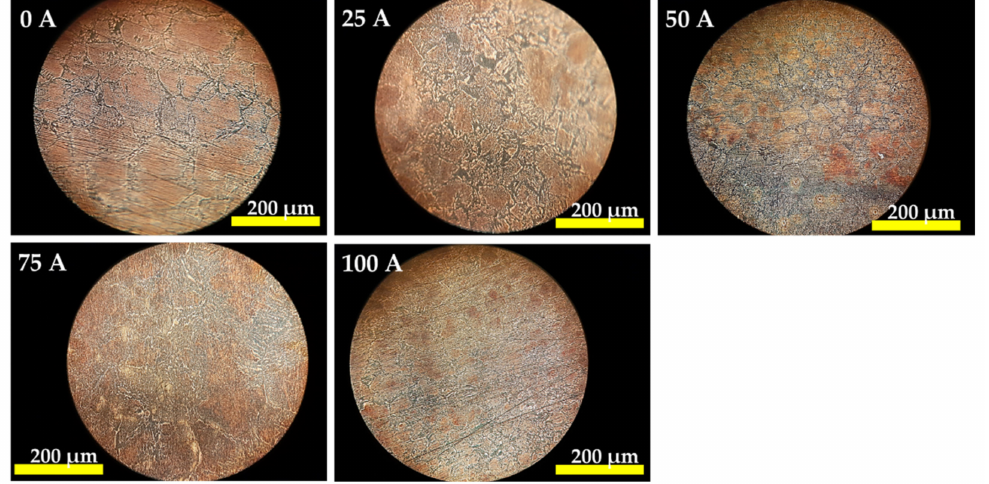
Figure 2. Optical micrograph of CGHAZ for conventional MIG welding for 0 A plasma MIG current, 25 A plasma MIG welding, 50 A plasma MIG welding, 75 A plasma MIG welding and 100 A plasma MIG welding under 20 ×